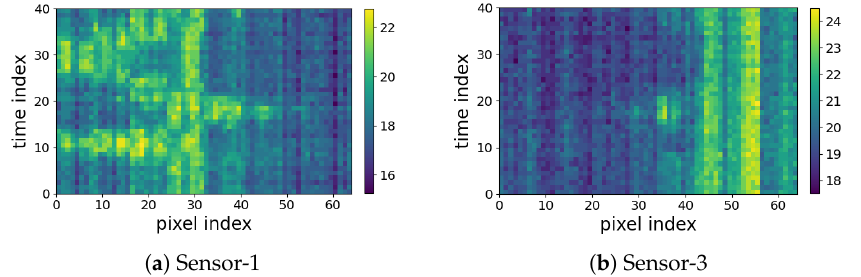
Figure 16. Comparison between Coventry-2018 Sensor-1 ( a ) and Sensor-3 ( b ) for “Standing + Small Movements”